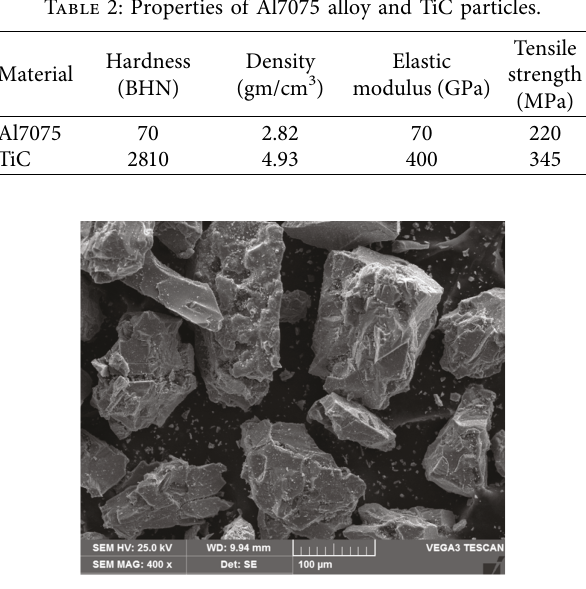
Figure 1: SEM of TiC